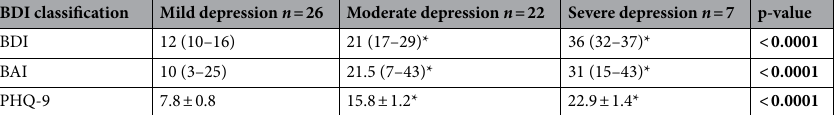
Table 1. Depression (BDI and PHQ-9) and anxiety (BAI) scores. Variables with normal distribution were analyzed by ANOVA and presented as mean ± standard error. Variables not normally distributed were analyzed by Kruskall–Wallis test and presented as median (minimum–maximum). *Vs. mild depression. Bold values indicate statistical significance of p < 0.05.